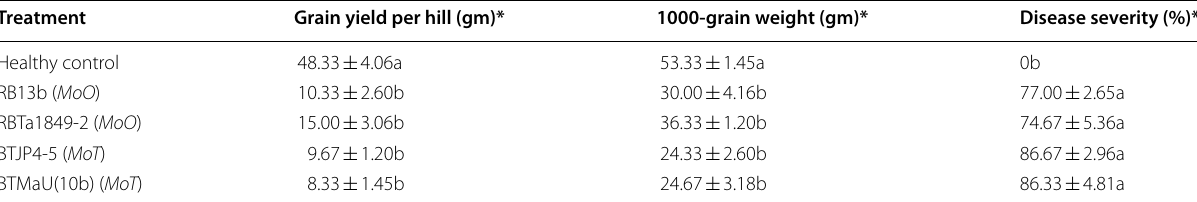
Table 1 Yield or yield components of the wheat variety BARI Gom‑25 under growth room condition after artificial inoculation with rice or wheat blast fungus